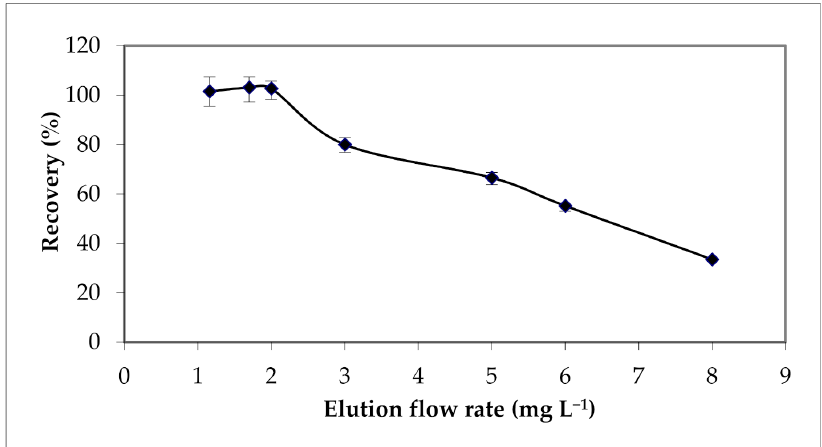
Figure 7. Effect of elution flow rate on the extraction yield of Cu (II). Solvent volume = 12 mL; [HNO 3 ] = 2